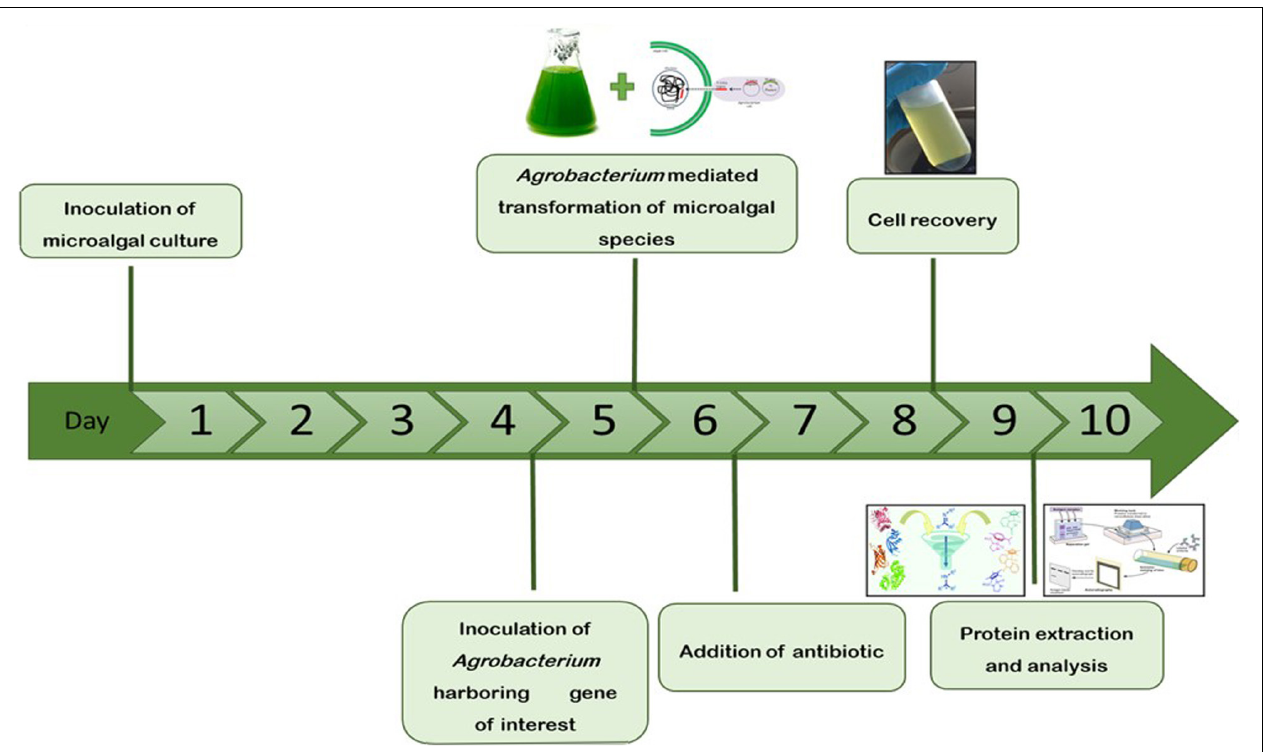
FIGURE 1 | Schematic representation and timeline for the production of recombinant proteins in microalgae by transient gene expression.